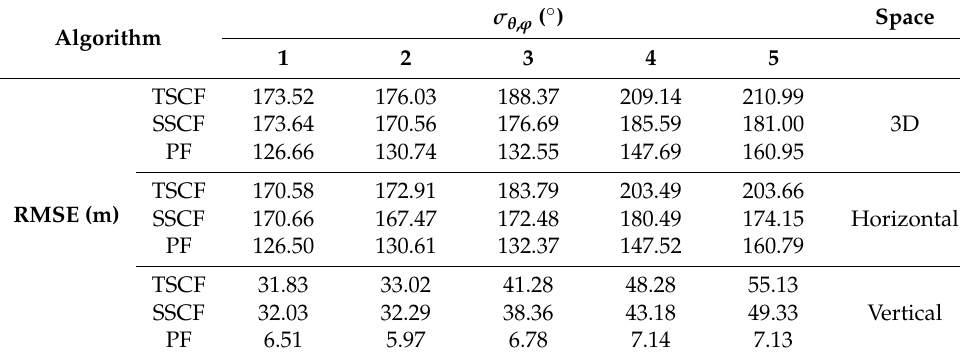
Table 3. RMSE results of the batch-processing solutions with certain UAS positions and using 11 measurement points.